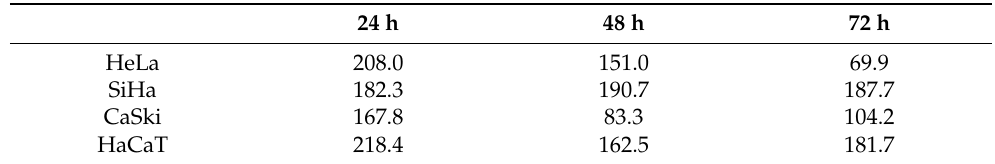
Table 1. Piperine inhibitory concentration (IC 50 ) in HeLa, SiHa, CaSki, and HaCaT cells at 24, 48, and 72